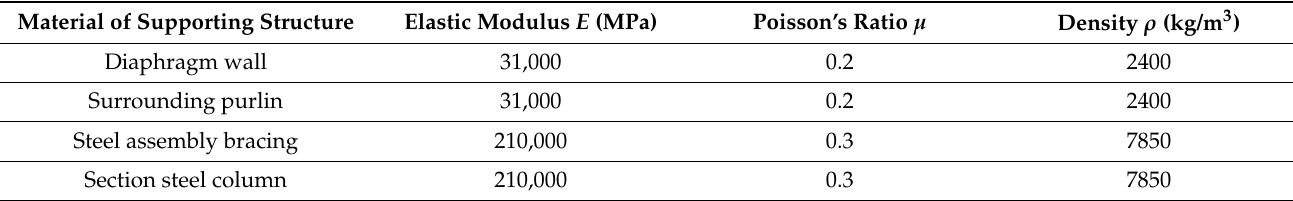
Table 2. Physical and mechanical parameters of steel assembly